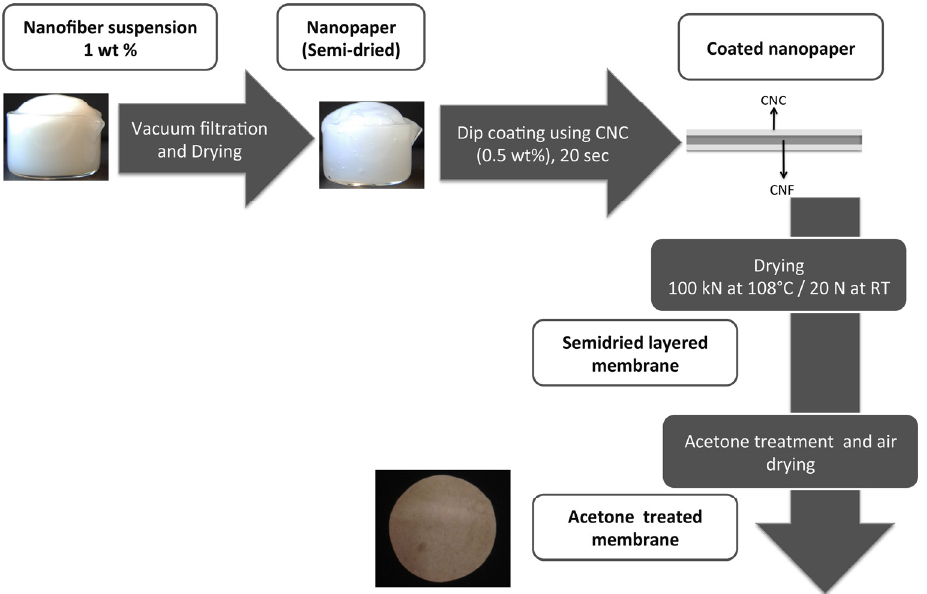
Figure 11. Schematic representation of membranes processing by Karim et al. [144]. Reproduced with permission from [143], copyright of Elsevier.